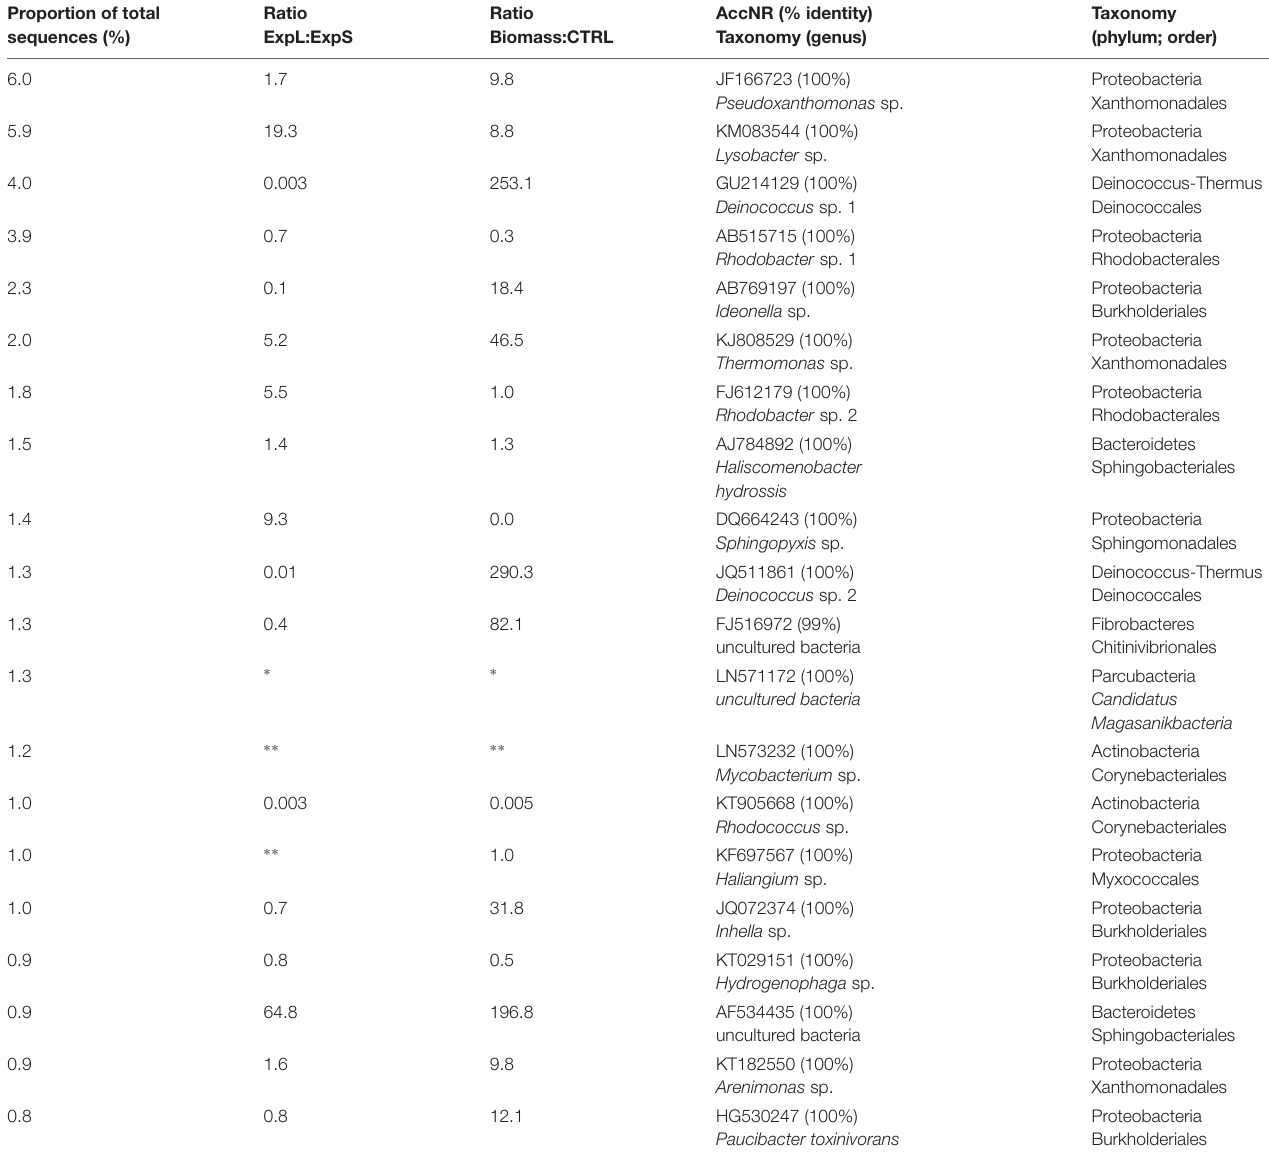
TABLE 1 | Top 20 most abundant OTUs present in the ExpL and